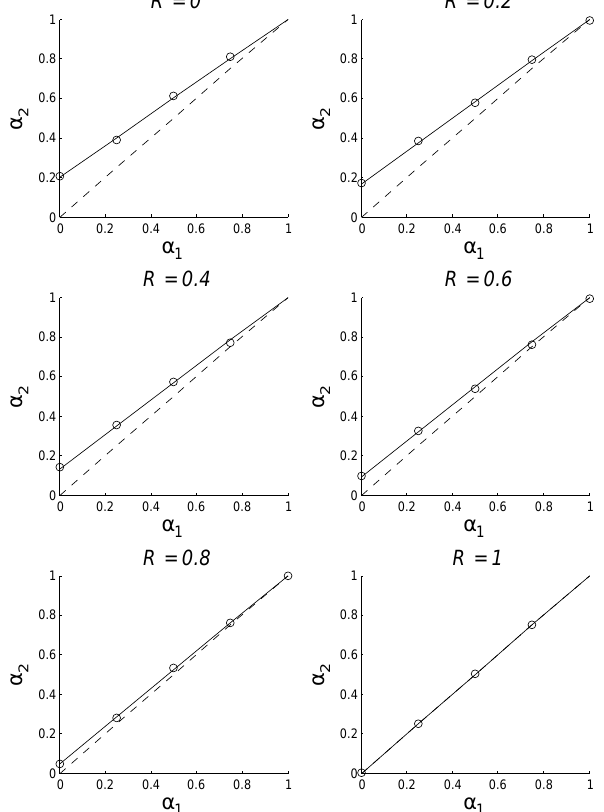
Figure 1. The dependence of α 2 on α 1 for cloud fractions (in ad- jacent grid boxes) that are uniformly distributed, where the vertical correlation coefficient in cloud cover ρ = 1 and the horizontal cor- relation coefficient in cloud cover is R (solid line). The dashed line is where there would be no scale dependence to α (i.e. α 2 = α 1 ) . The circles are values given by